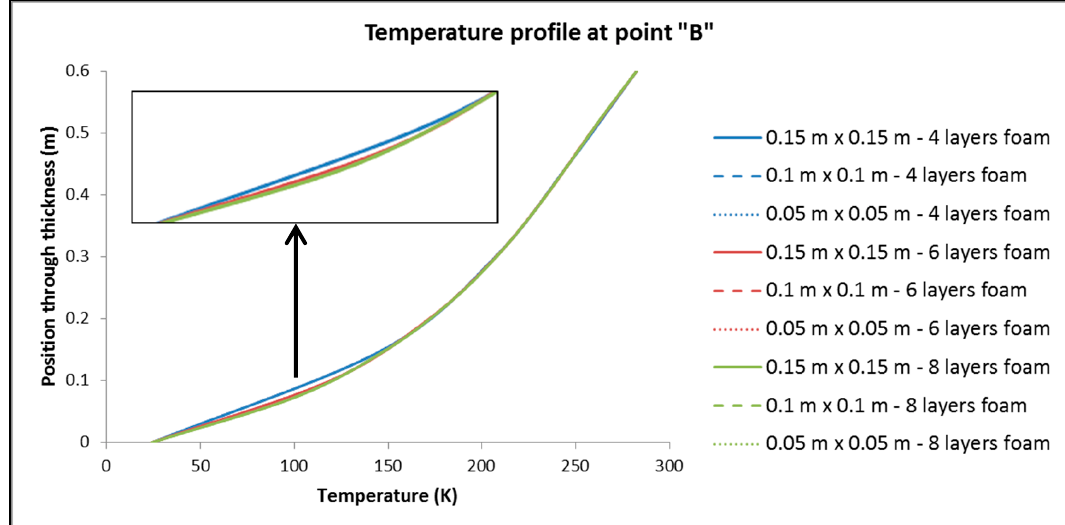
Figure 8. Temperature profile through the insulation thickness at point “C” of Figure 5. From Table 3 and Figures 6–8, we have: (1)